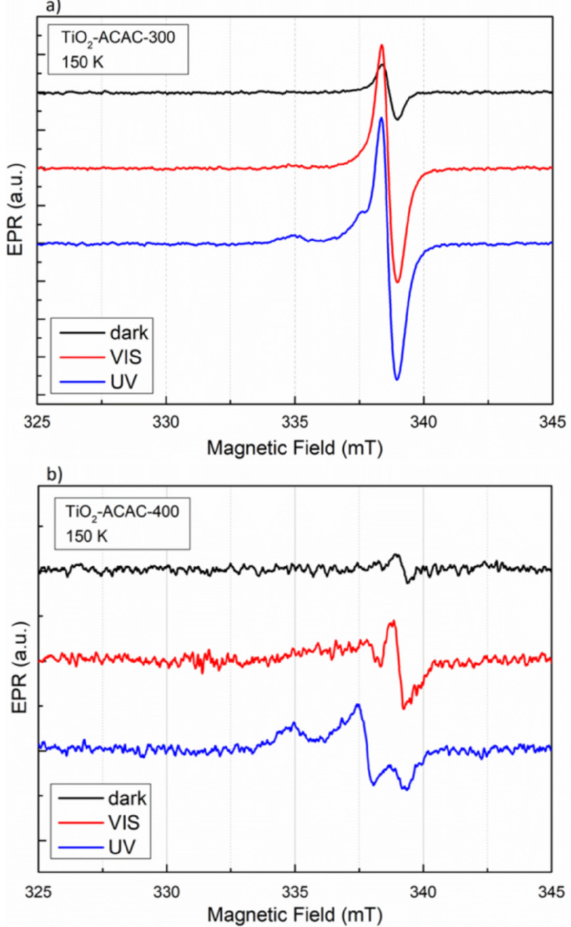
Figure 6. EPR spectra of ( a ) TiO 2 -ACAC-300 and ( b ) TiO 2 -ACAC-400 at 150 K.